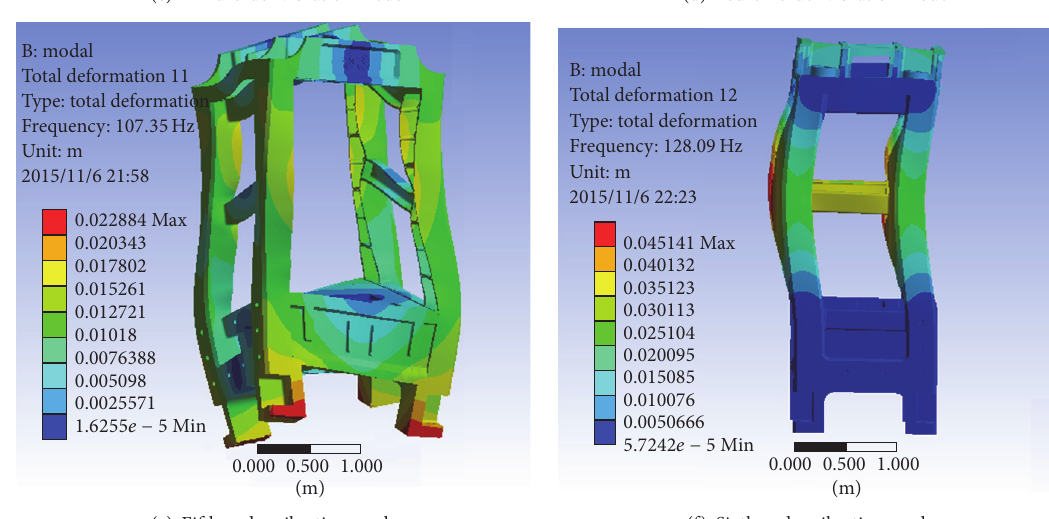
Figure 15: Modes of the first six orders of vibration of the